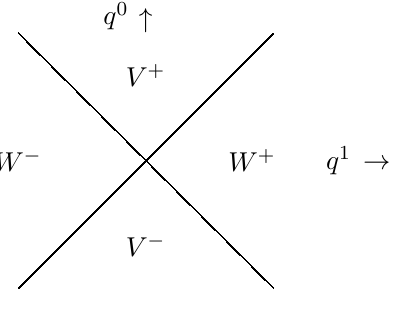
Figure 5 . The four regions V (cid:6) and W (cid:6) in the two dimensional momentum